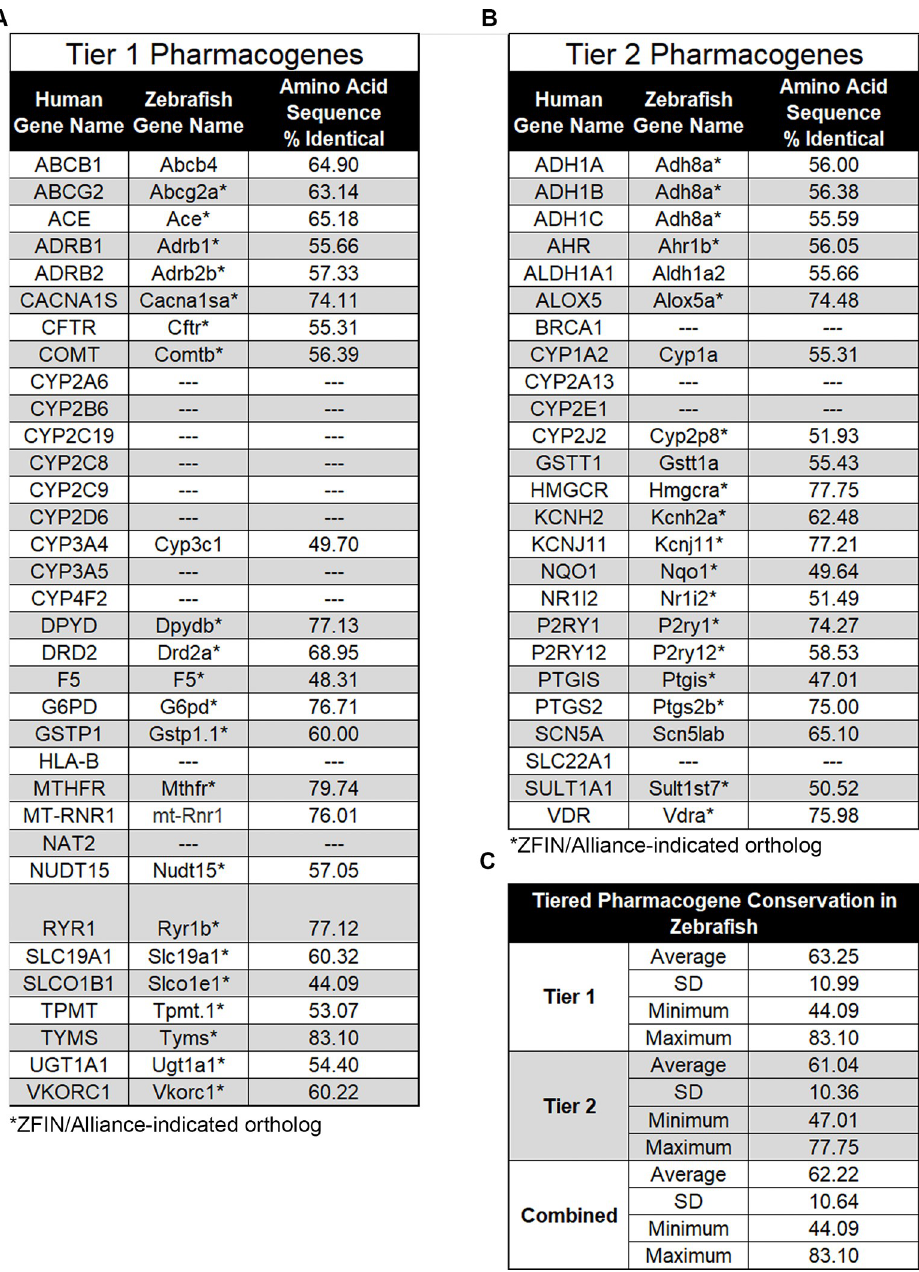
Fig 2. Pharmacogene orthologs and amino acid conservation. Tables with Tier 1 (A) and Tier 2 (B) human pharmacogenes (left), the orthologous zebrafish gene (middle), and the conservation in amino acid sequence as determined by NCBI BLAST. C. Summary tables of averages, standard deviation (SD), minimum, and maximums for Tier 1, Tier 2, and combined. � indicates ZFIN/Alliance-indicated ortholog. were members of the Cytochrome P450 (CYP) family of polymorphic enzymes, 1 was Human Leukocyte Antigen (HLA), and the last was N-acetyltransferase 2 (NAT2). The Tier 2 pharma- cogenes lacking a zebrafish ortholog included two members of the Cyp-family, Breast Cancer Type 1 (BRCA1), and the solute transporter SLC22A1.